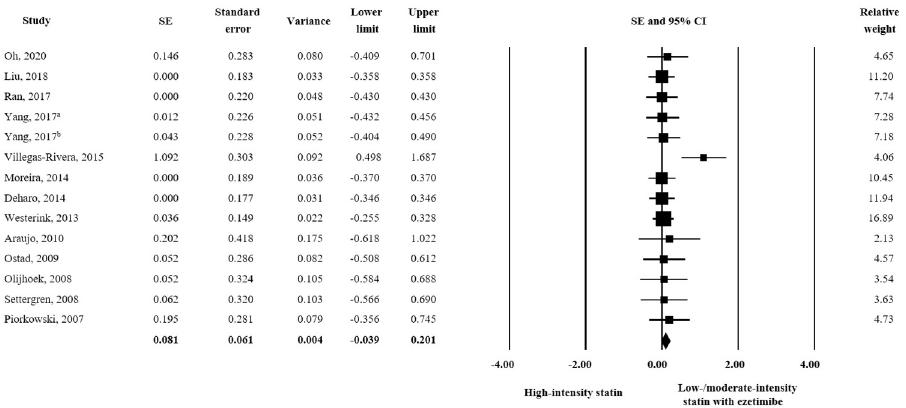
Fig 5. Forest plot of efficacy evaluation results. Changes in HDL-C observed for high-intensity statin monotherapy and low/moderate-intensity statin plus ezetimibe combination therapy. a rosuvastatin 20 mg vs. rosuvastatin 5 mg plus ezetimibe 10 mg; b rosuvastatin 20 mg vs. rosuvastatin 10 mg plus ezetimibe 10 mg.